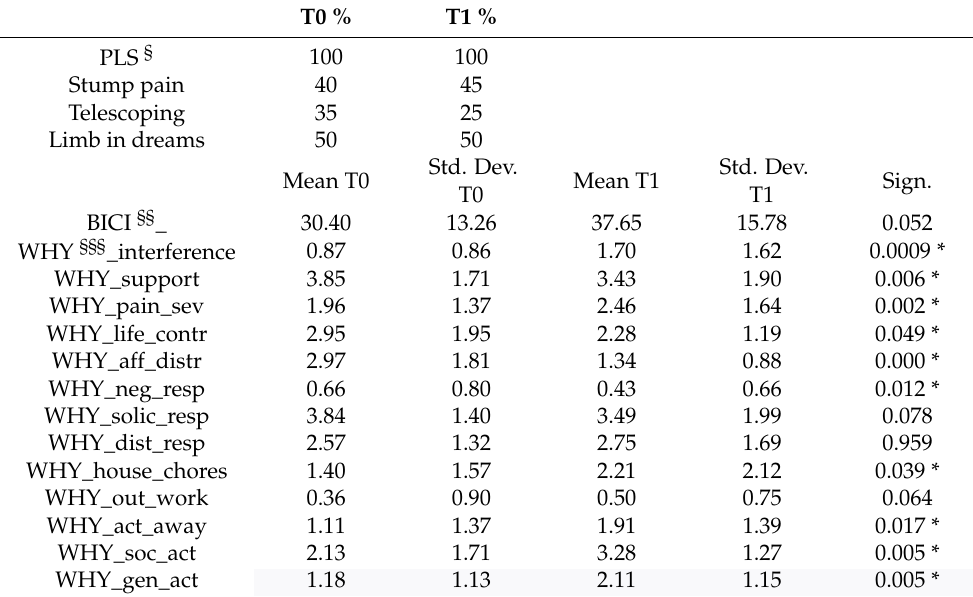
Table 1. Clinical data percentage and Wilcoxon Test results between T0 and T1 questionnaires